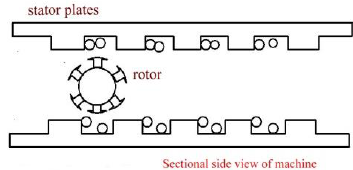
Figure 2. Sectional side view of the linear rotating generator.